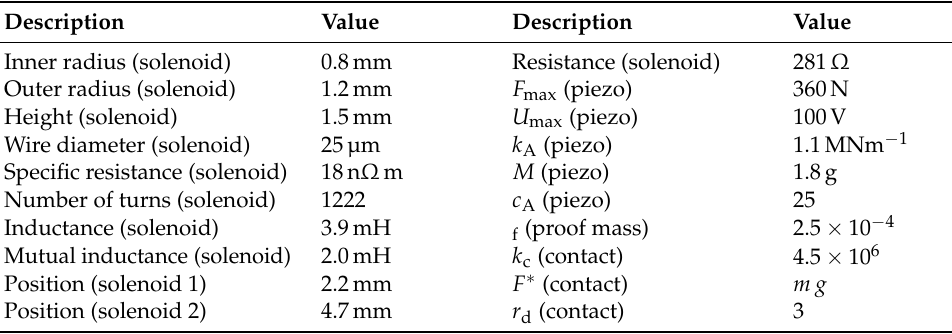
Table 3. Fixed design parameters that are used in the